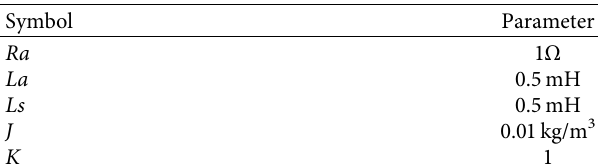
Table 5: DC motor parameter.